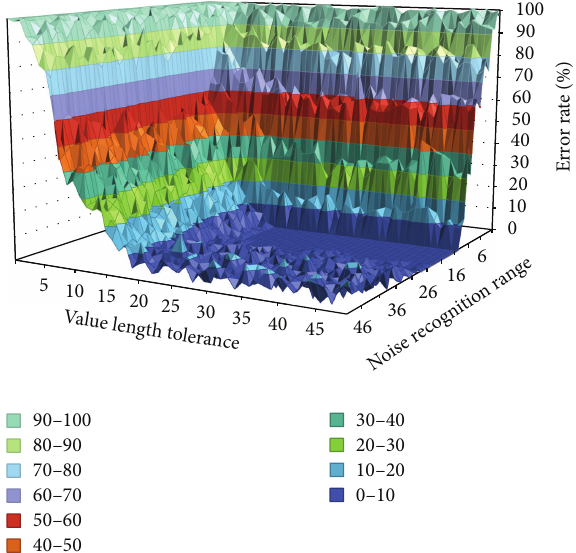
Figure 9: FAR and FRR performance of Key 1.